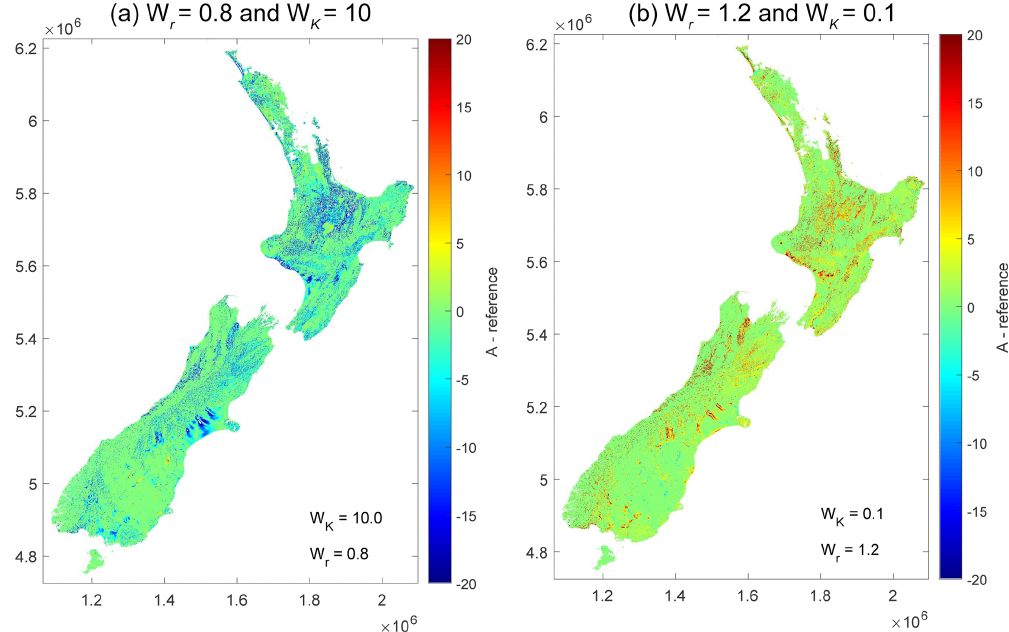
Figure 17. Output of two models runs with different weights for recharge ( W r ) and K ( W K